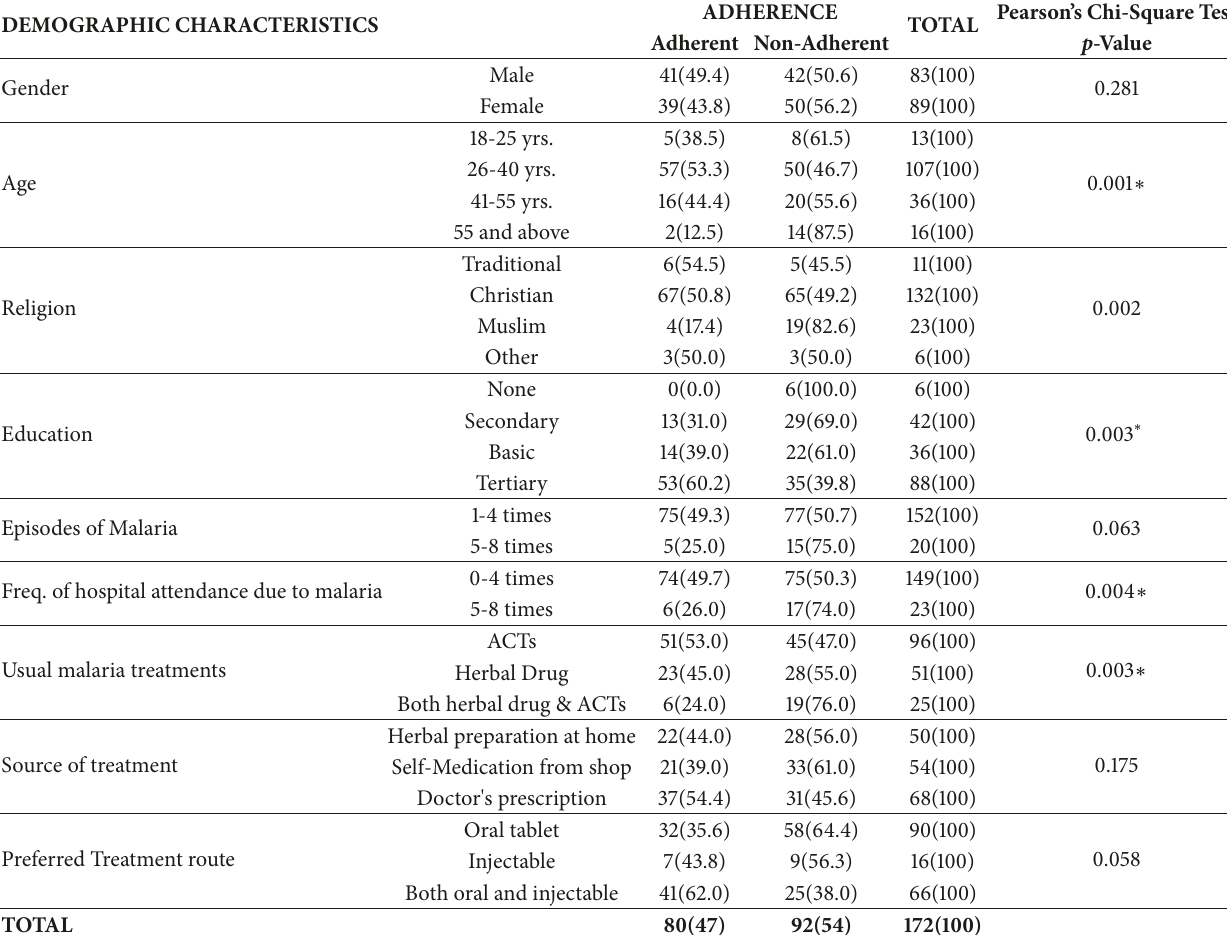
Table 2: Respondents’ adherence stratified by the demographic characteristics.